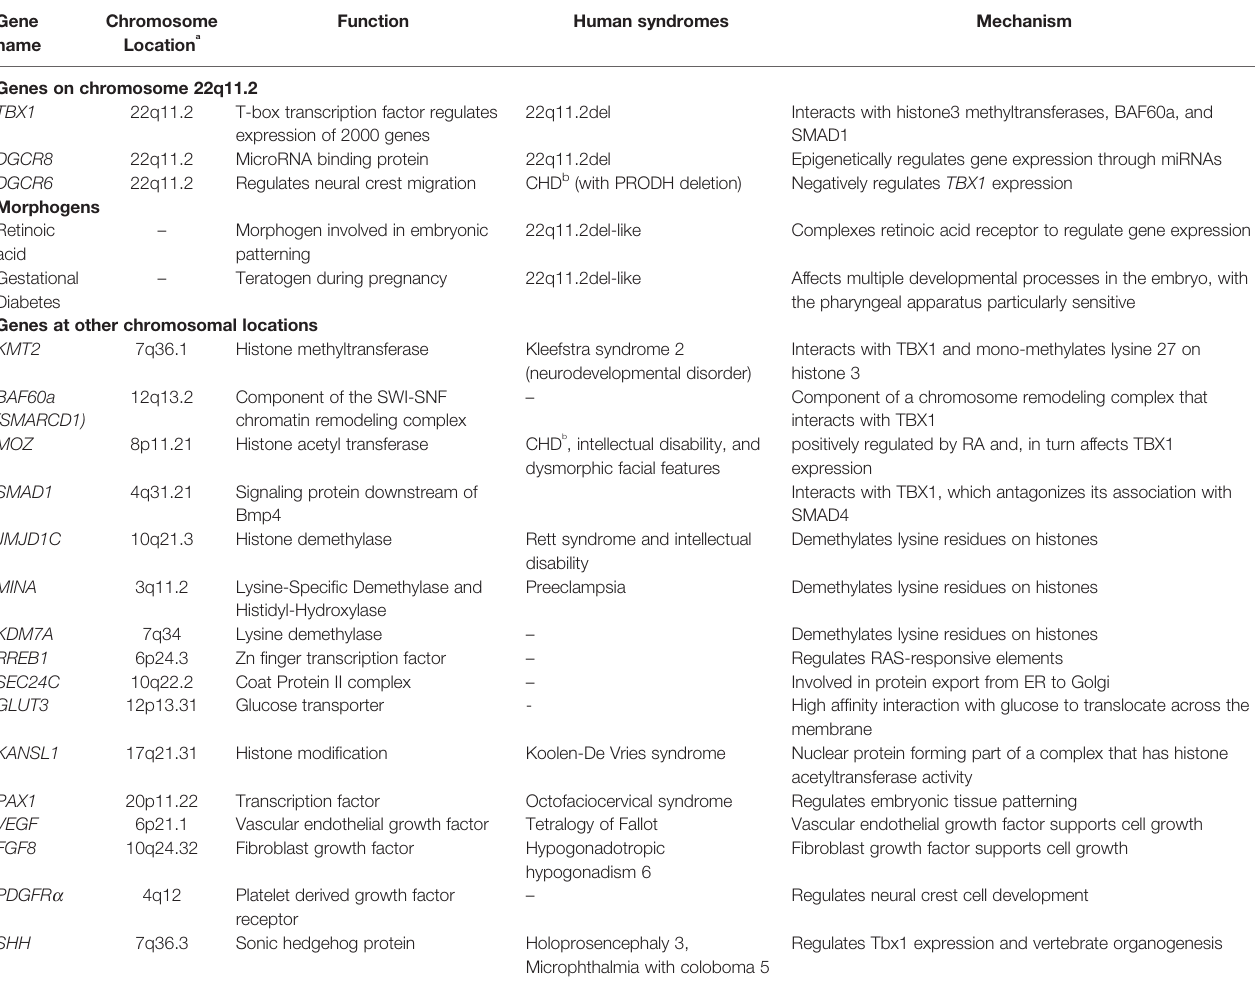
TABLE 3 | Genetic and epigenetic modi fi ers of 22q11.2 deletion syndrome with disease